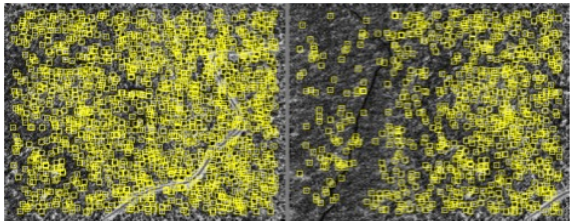
Figure 6: Keypoints extracted with SIFT detector